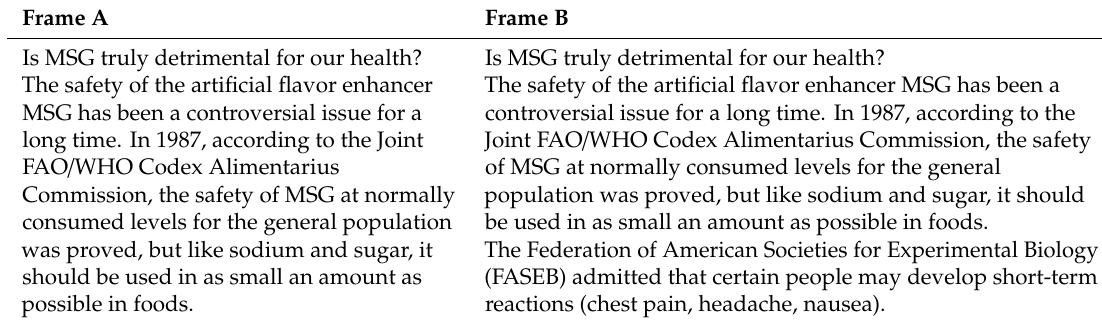
Table 1. Di ff erence in messages between frame A and frame